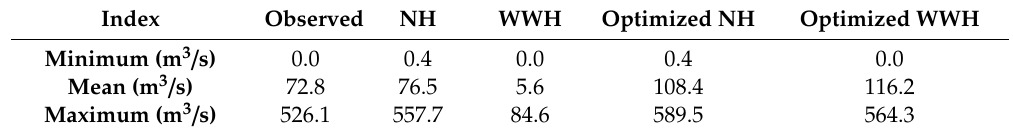
Table 6. Basic statistical parameters (minimum, mean, and maximum) at Garbey Kourou in the